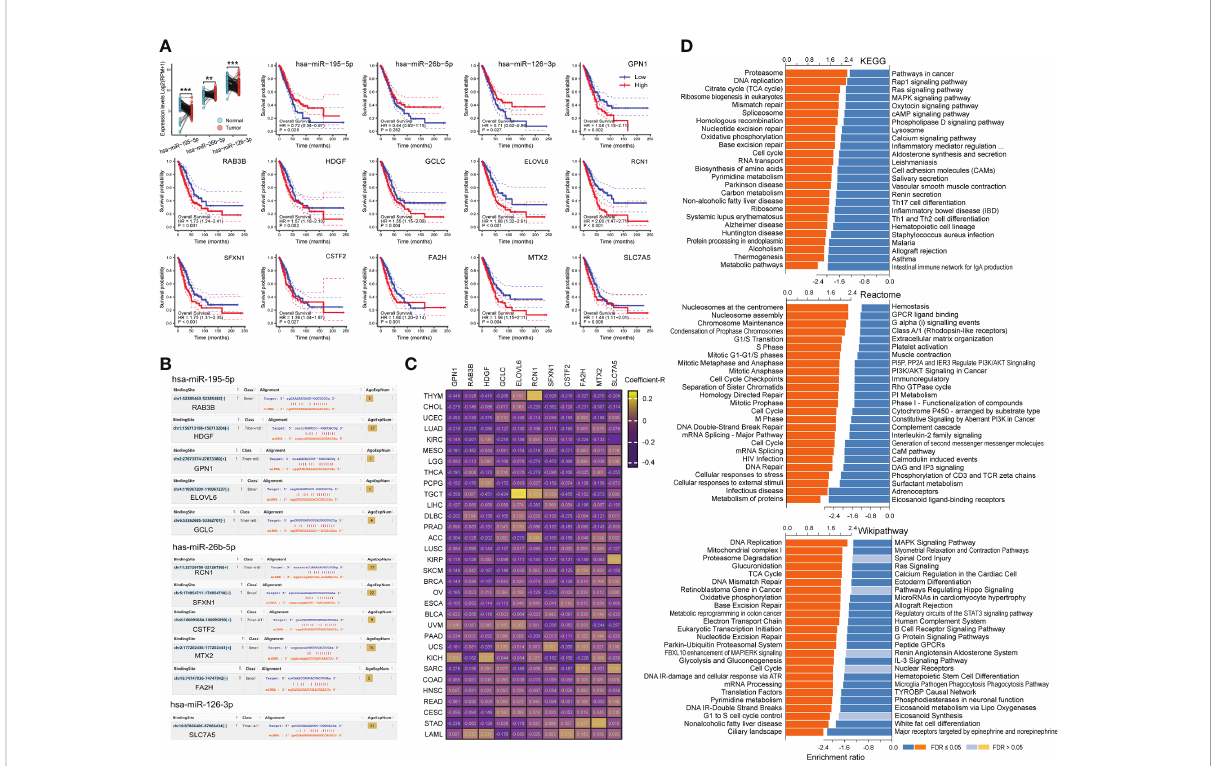
FIGURE 5 Binding site of core-miRNAs and their effects. (A) The expression of core-miRNAs in paired LC samples in TCGA was shown, and the effects of miRNA/mRNA on the overall survival of LUAD patients were calculated by Kaplan-Meier method. (B) The binding sites of miRNAs were shown. (C) Heatmap shown the expression correlation Coef fi cient-R of miRNA-mRNA calculated by ENCORI across pan-cancer. (D) The functional enrichment analysis of core-miRNA target genes in LUAD was performed by GSEA through the LinkCompare module of